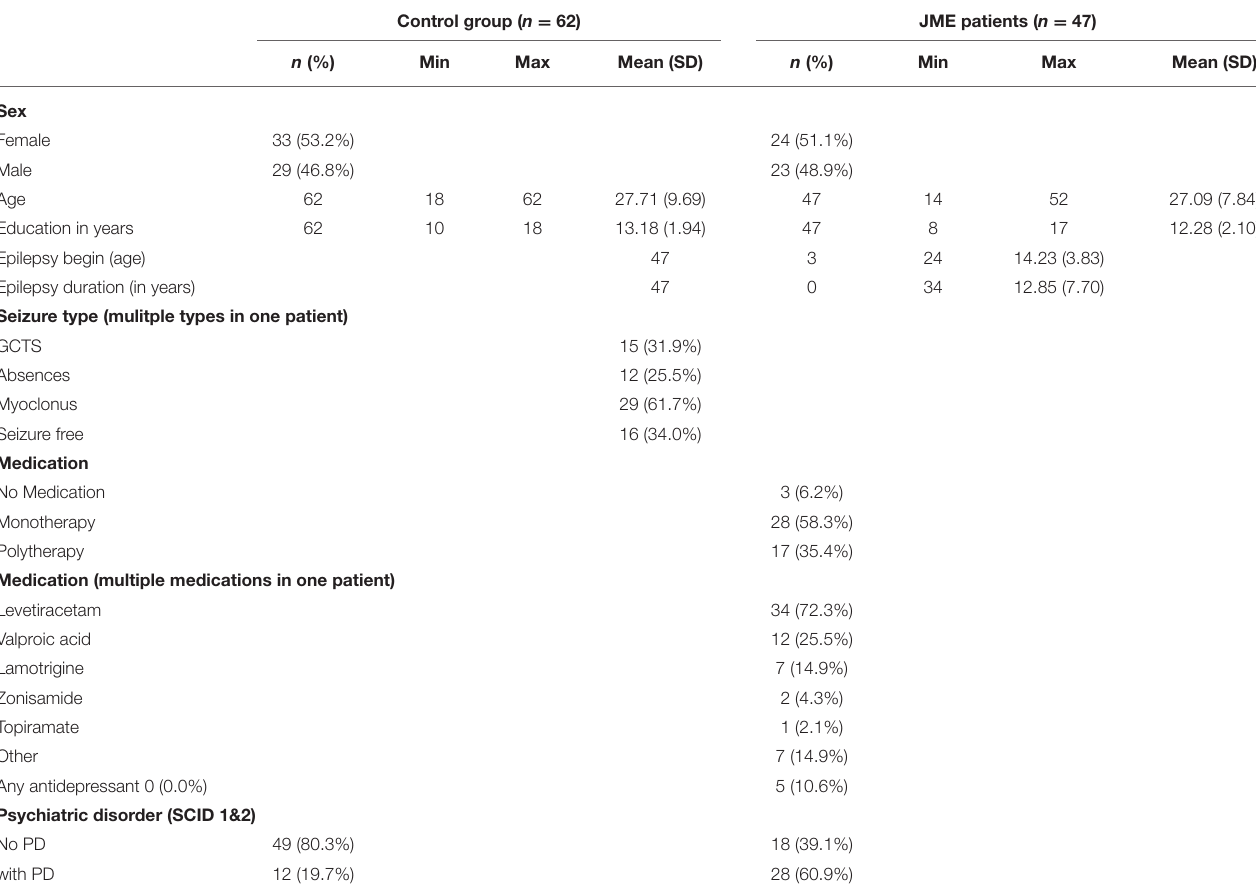
TABLE 2 | Descriptive statistics of